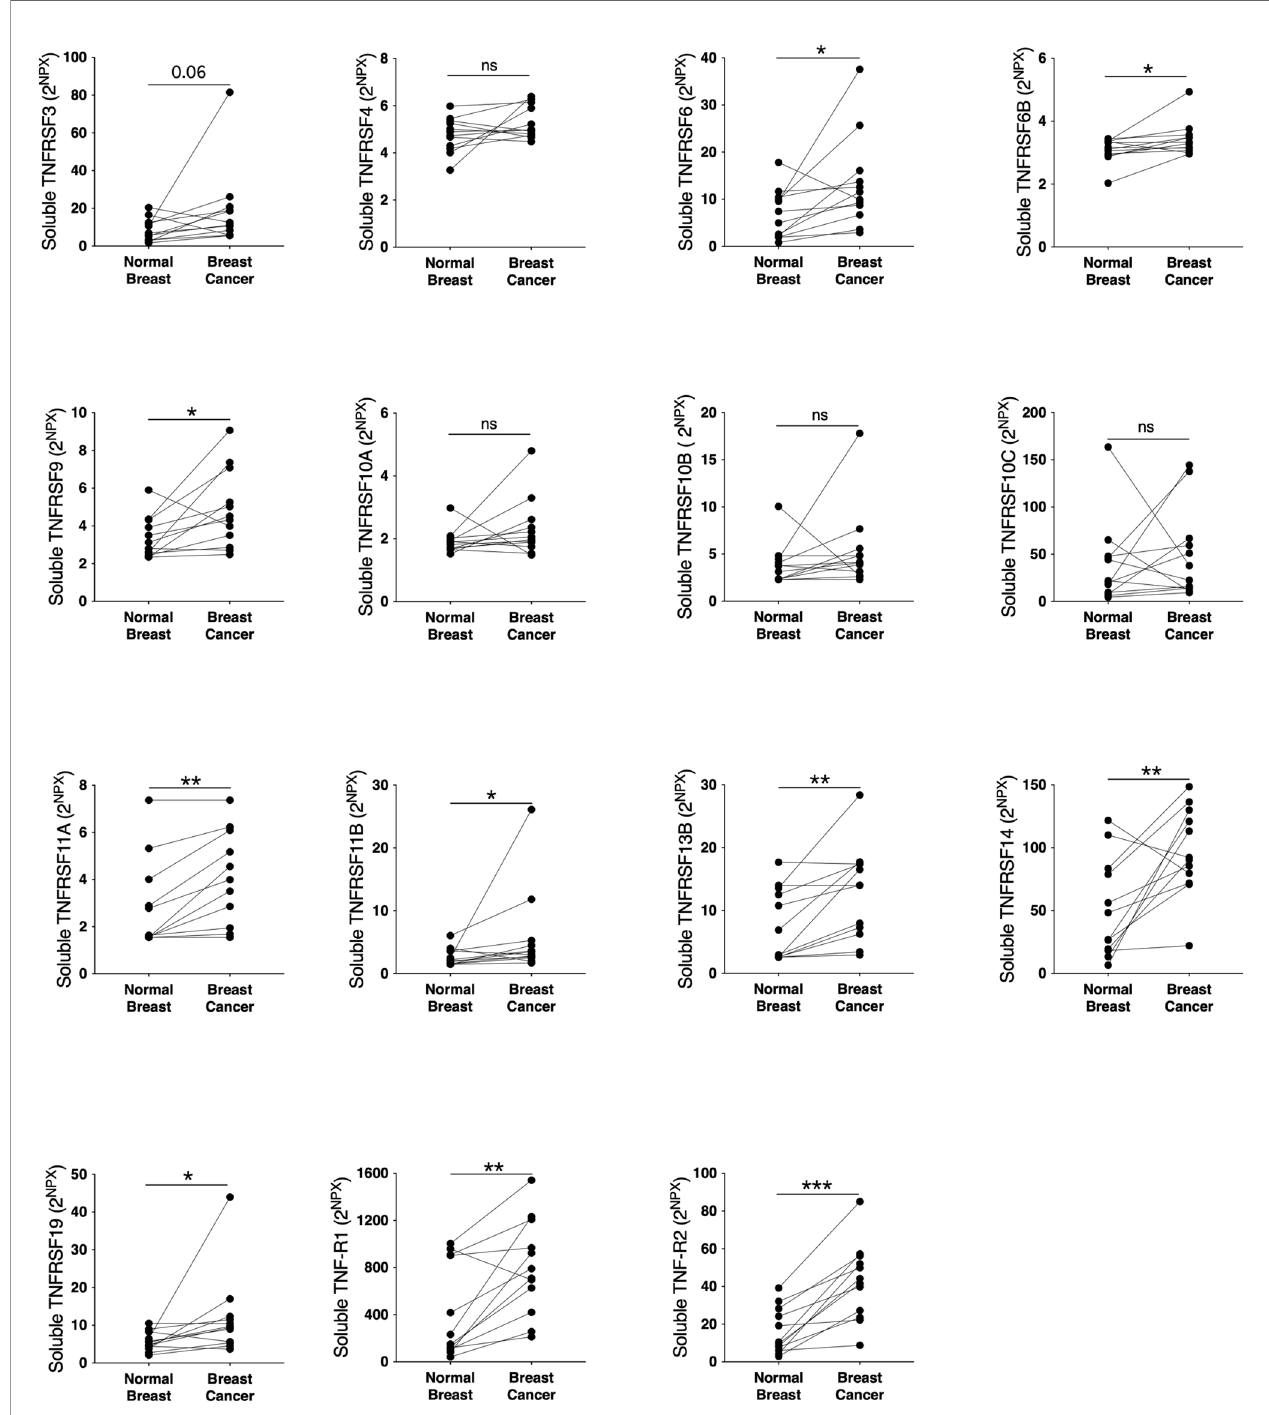
FIGURE 2 | Extracellular levels of soluble TNFRSF in vivo in breast cancers and adjacent normal breast tissue. 12 patients with estrogen receptor positive breast cancer underwent microdialysis before surgery. One catheter was inserted into the breast cancer and another into adjacent normal breast tissue. Proteins were quanti fi ed using proximity extension assay. Data represents protein abundance in linear values (2 NPX as described in the materials and methods section). * P < 0.05, ** P < 0.01, *** P < 0.001, ns, not signi fi